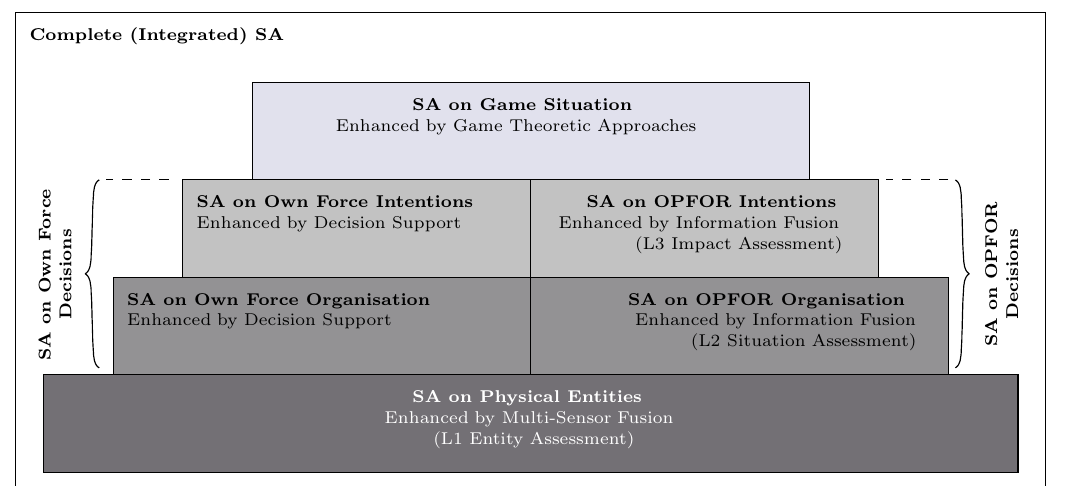
Figure 4: Levels of Situation Awareness(SA)